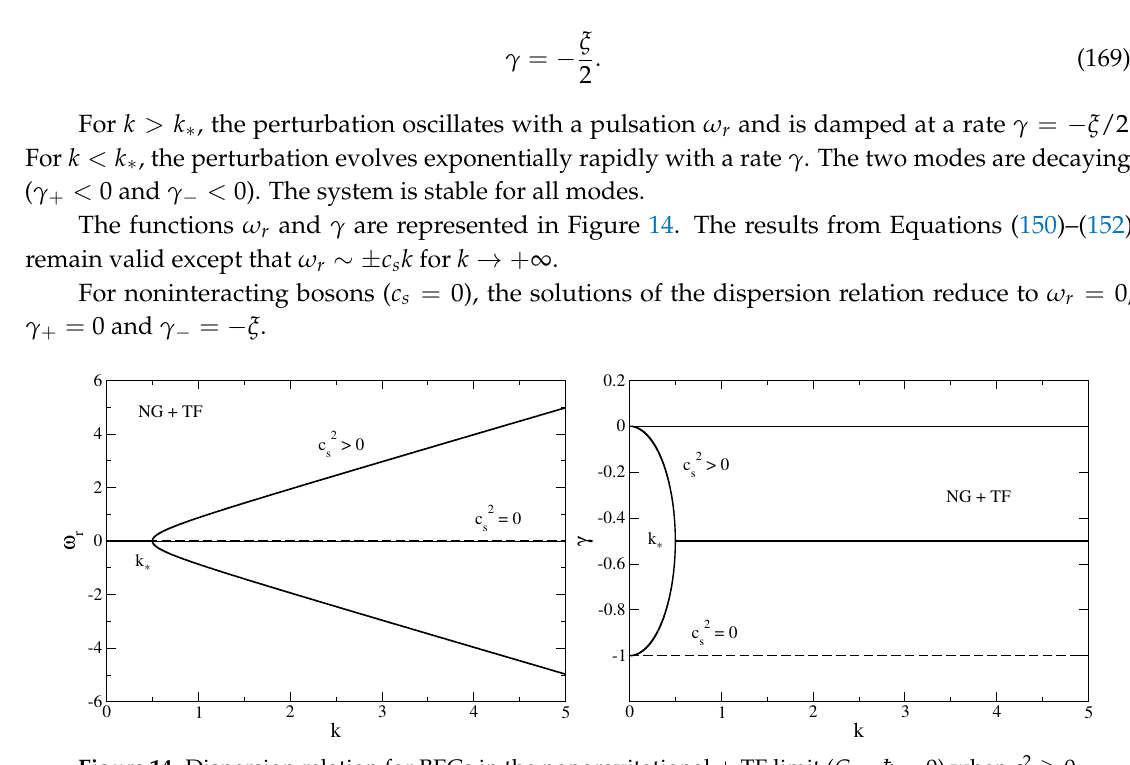
Figure 14. Dispersion relation for BECs in the nongravitational + TF limit ( G = ¯ h = 0) when c 2 s ≥ 0. We have normalized the wavenumber by ξ / c s and the pulsation by ξ . This is equivalent to taking ξ = c s = 1 in the dimensional